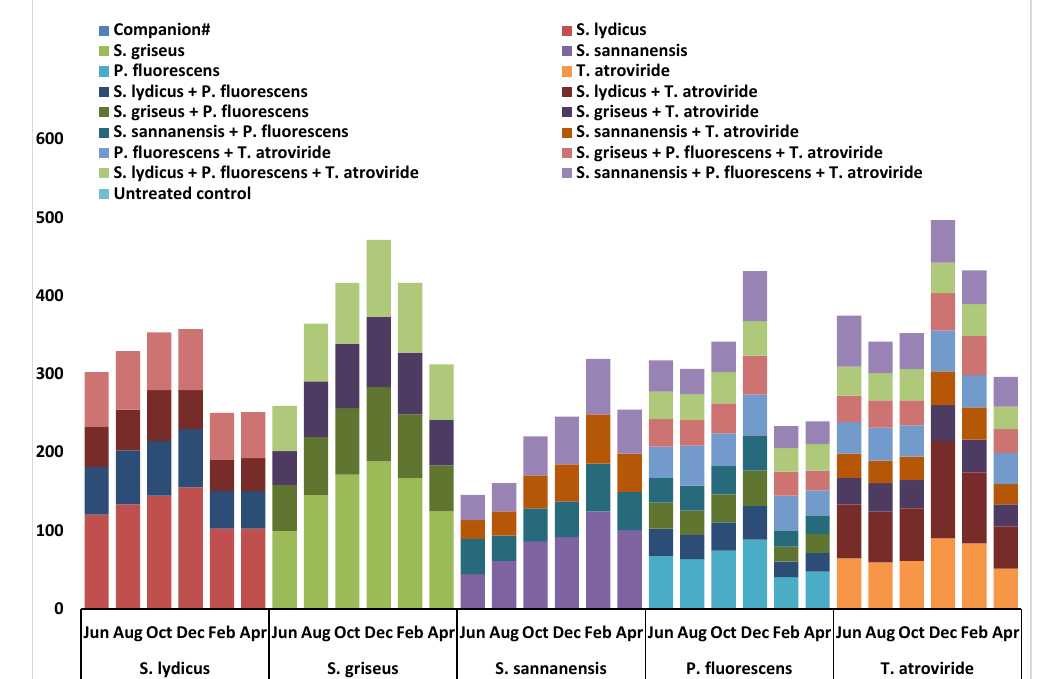
Fig. 2: Population densities of individual biocontrol agents after imposing various treatments in turmeric soils*